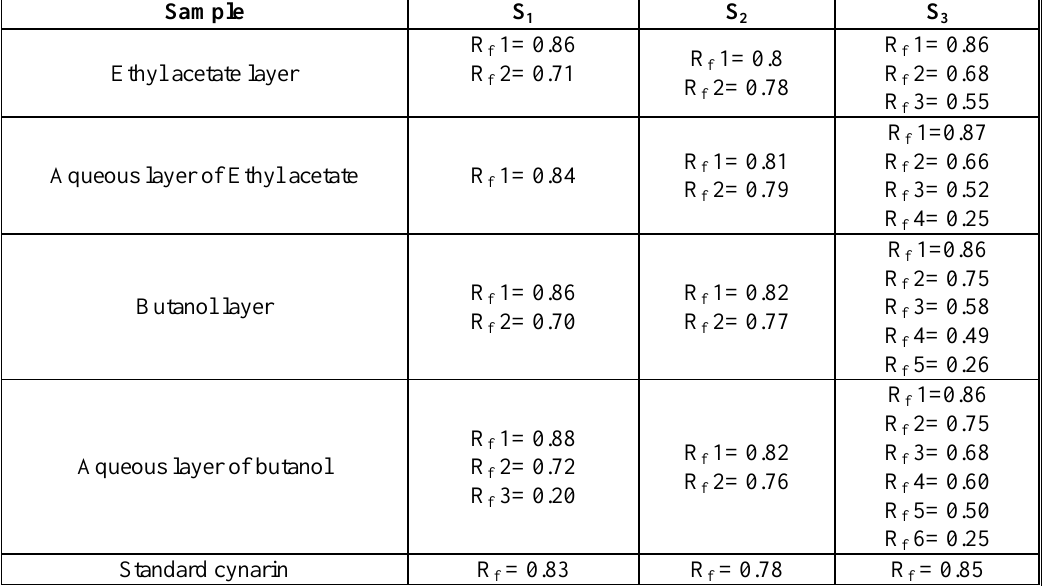
Table 2: Results of TLC for Artichoke leaves from (Greaat controlled farm by Agriculture College of Baghdad University)